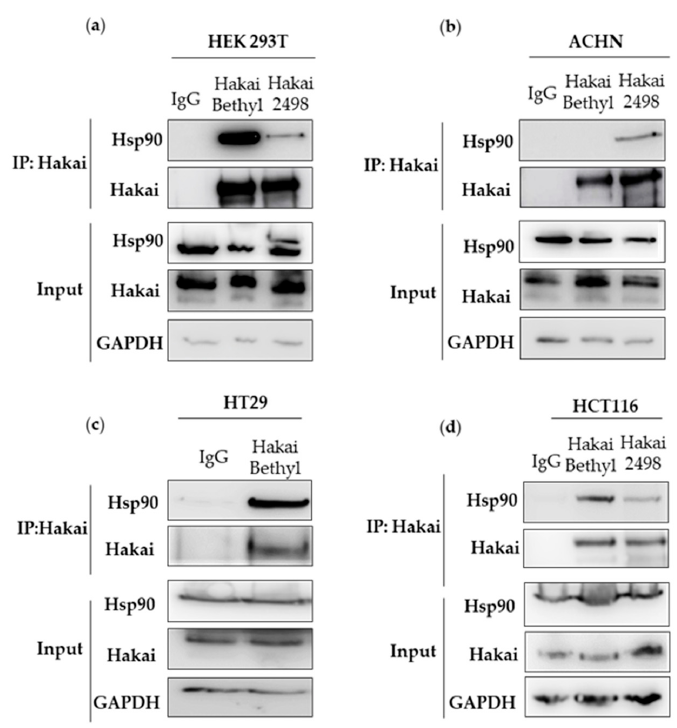
Figure 1. Hakai interacts with heat shock protein 90 (Hsp90): Co-immunoprecipitation of Hakai and Hsp90 was performed in different cell lines: ( a ) HEK293T. ( b ) ACHN. ( c ) HT29. ( d ) HCT116. Hakai immunoprecipitation was performed by employing two different rabbit polyclonal Hakai antibodies indicated in material an methods: one from Bethyl (Bethyl Ab) and one kindly provided by Dr. Fujita (Hakai-2498). GAPDH signal was used as protein loading control.